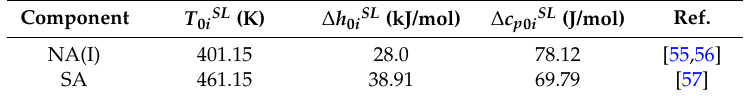
Table 2. Melting properties of nicotinamide (NA, form I) and succinic acid (SA).